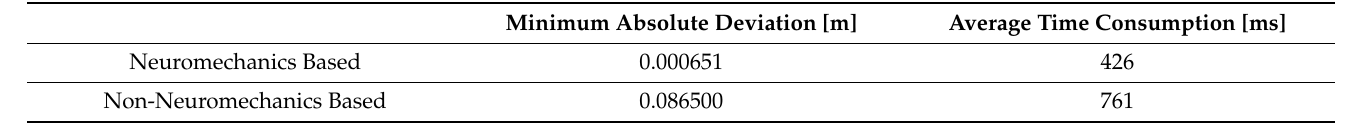
Figure 8. Movement trajectories (start from (0.7,0) and end at (0.3,0.65)) generated by the musculoskeletal arm under neuromechanics—based and non—neuromechanics—based neural feedback controllers. Table 6. Comparison I of the effectiveness of neural feedback controllers that are based on neurome- chanics and those that are Table 7. Comparison Ⅱ of the e ff ectiveness of neural feedback controllers that are based on neuro- mechanics and those that are not.